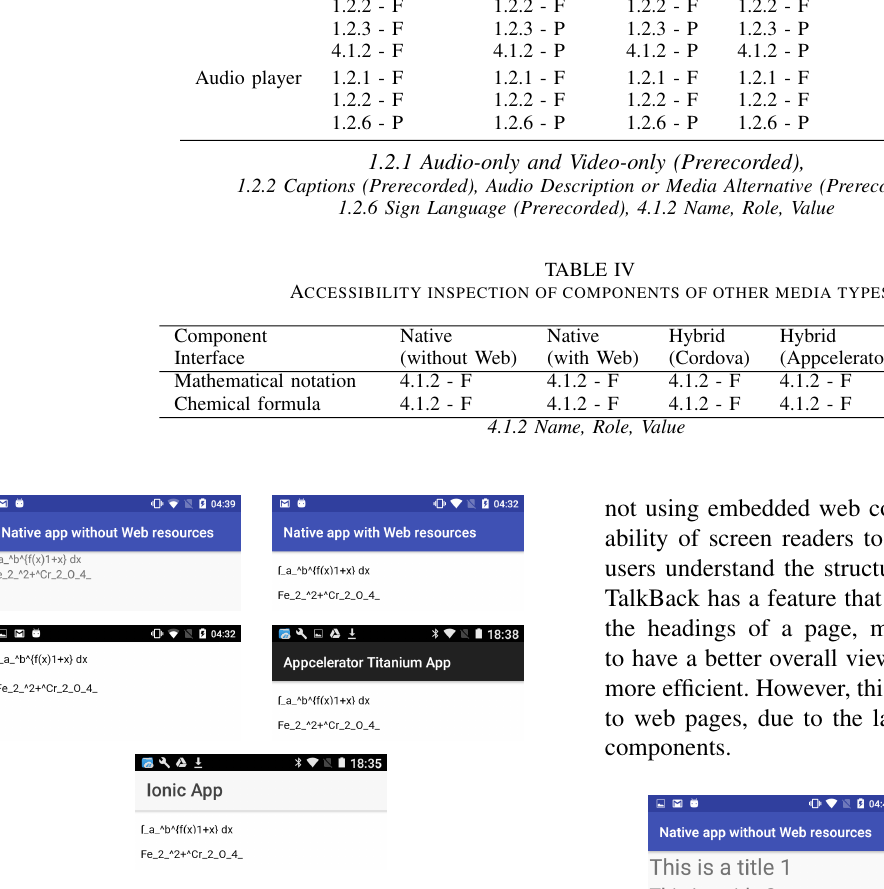
Fig. 4. Components ”mathematical notation” and ”chemical formula” imple- mented in the native application (without Web resources), native application (with Web resources), Cordova application, Appcelerator application and Ionic application, respectively.